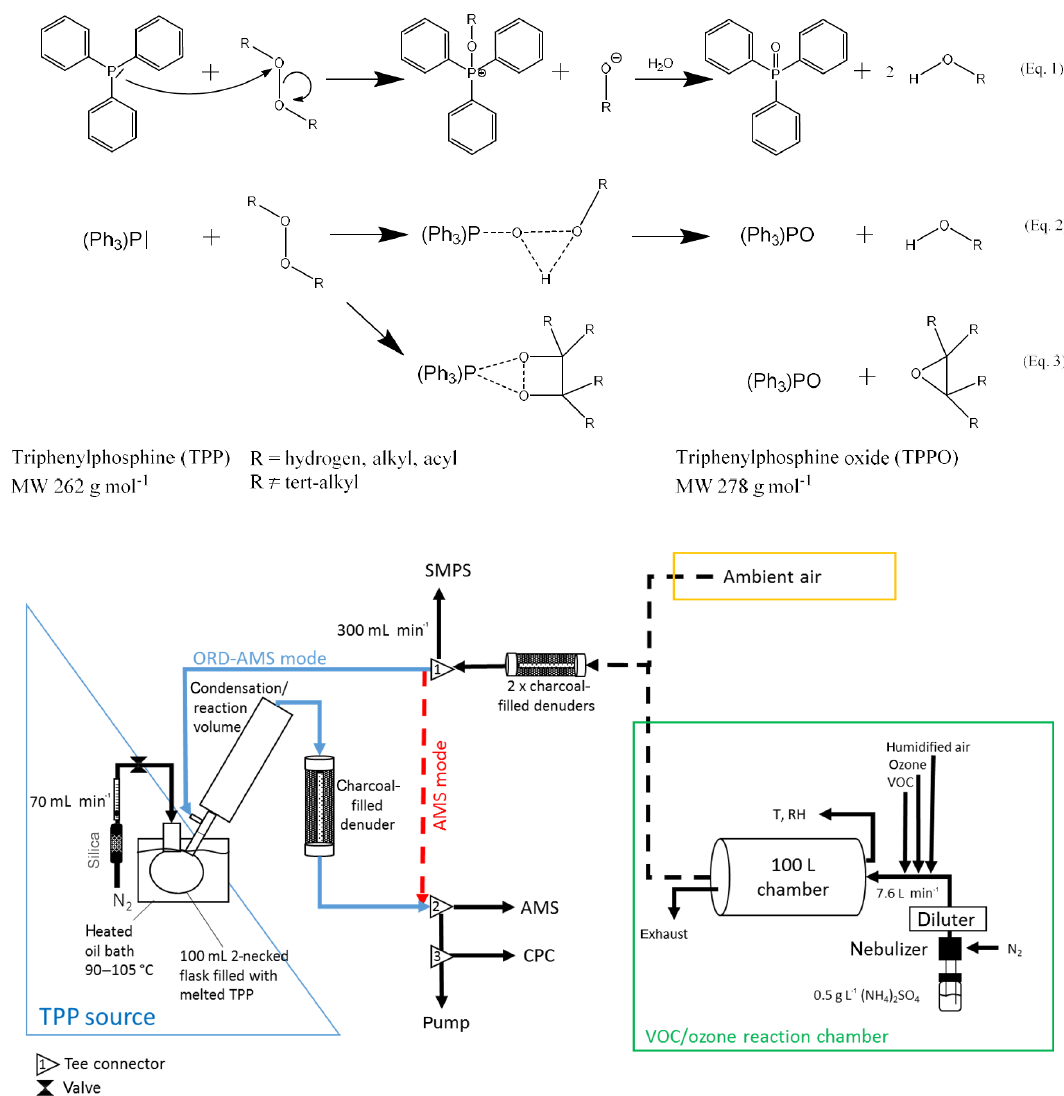
Figure 1. Experimental setup: the aerosol is either generated with a 100L reaction chamber via VOC–O 3 reaction, usually also introducing AS seed particles, or supplied from outside of the chemistry building. The aerosol is then led to the aerosol mass spectrometer, either directly (AMS mode, red arrow) or through the online derivatization unit (ORD-AMS mode) in which the test aerosol is mixed with a nitrogen stream containing supersaturated gaseous TPP. Remaining gaseous TPP is removed by charcoal-filled denuder after the condensation/reaction volume. Most of the time the aerosol is characterized by the ToF-AMS, an SMPS system and a